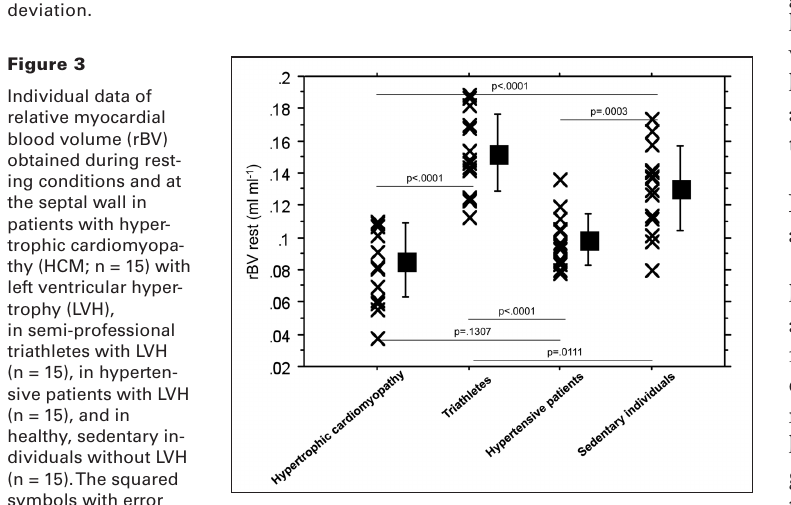
Individual data of myo- cardial blood flow reserve (MBFR) ob- tained at the septal wall in patients with hypertrophic car- diomyopathy (HCM; n = 15) with left ven- tricular hypertrophy (LVH), in semi-profes- sional triathletes with LVH (n = 15), in hyper- tensive patients with LVH (n = 15), and in healthy, sedentary in- dividuals without LVH (n = 15). The squared symbols with error lines indicate mean values ± standard deviation.